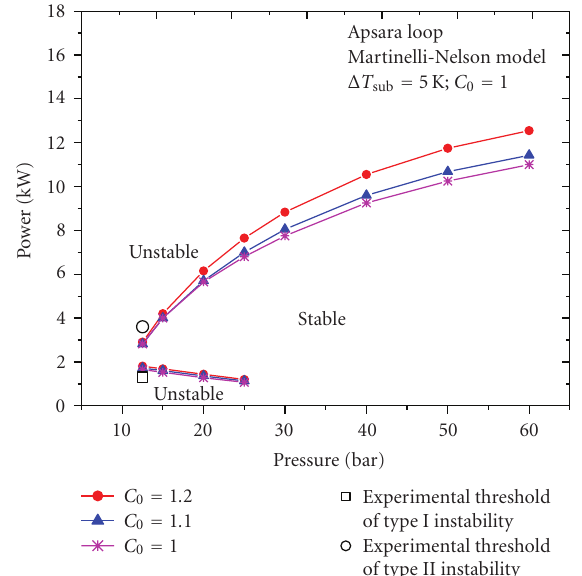
Figure 12: E ff ect of void distribution parameter on threshold of Type I and Type II instabilities observed in the Apsara